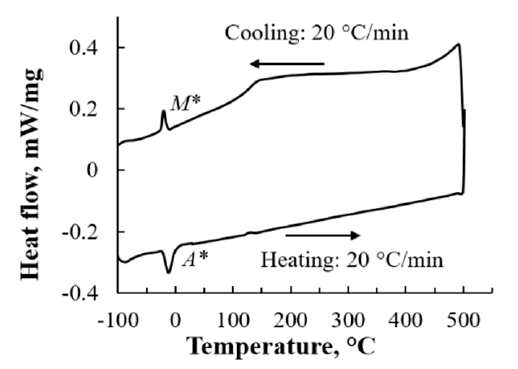
Figure 5. DSC cooling and heating curves of 10th cycled equiatomic CuZr alloy with maximum temperature of 500 °C.